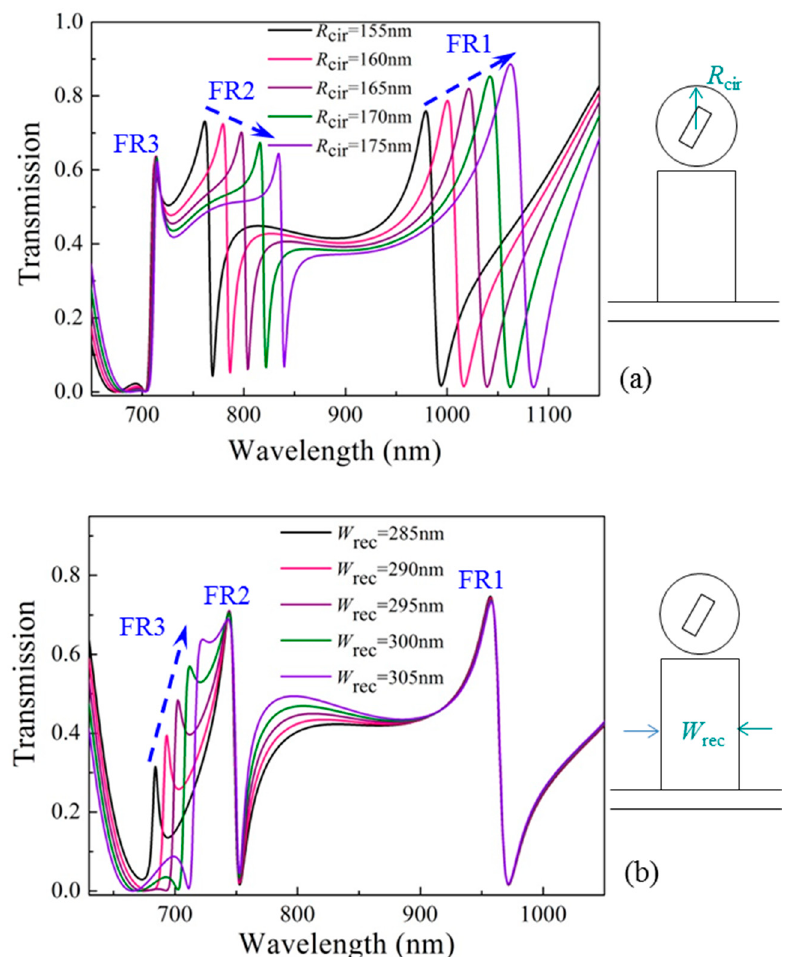
Figure 3. Transmission changes for ( a ) different radii of the circular cavity, R cir = 155 nm, 160 nm, 165 nm, 170 nm, 175 nm; ( b ) different widths of the rectangular cavity, W rec = 285 nm, 290 nm, 295 nm, 300 nm, 305 nm.